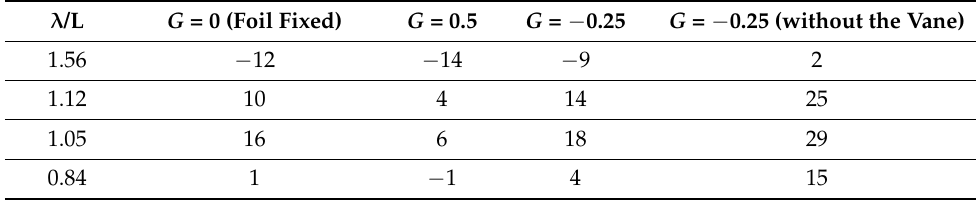
Table 1. Performance enhancement (%) by the dynamic